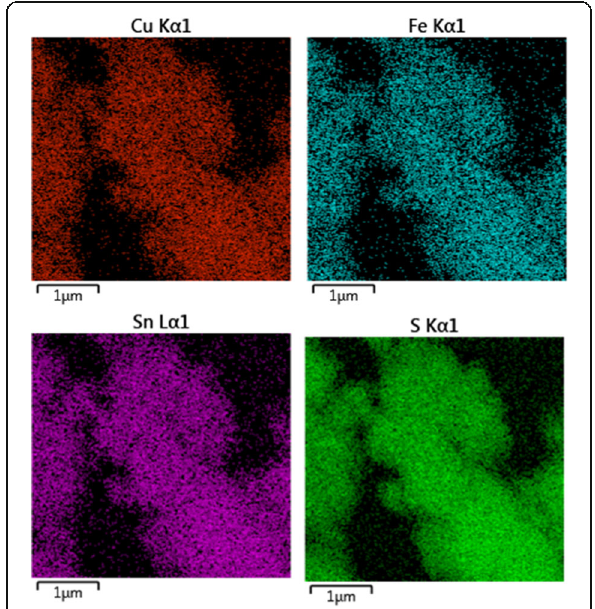
Fig. 6 Distribution of Cu, Fe, Sn, and S elements obtained by mapping of the CFTS